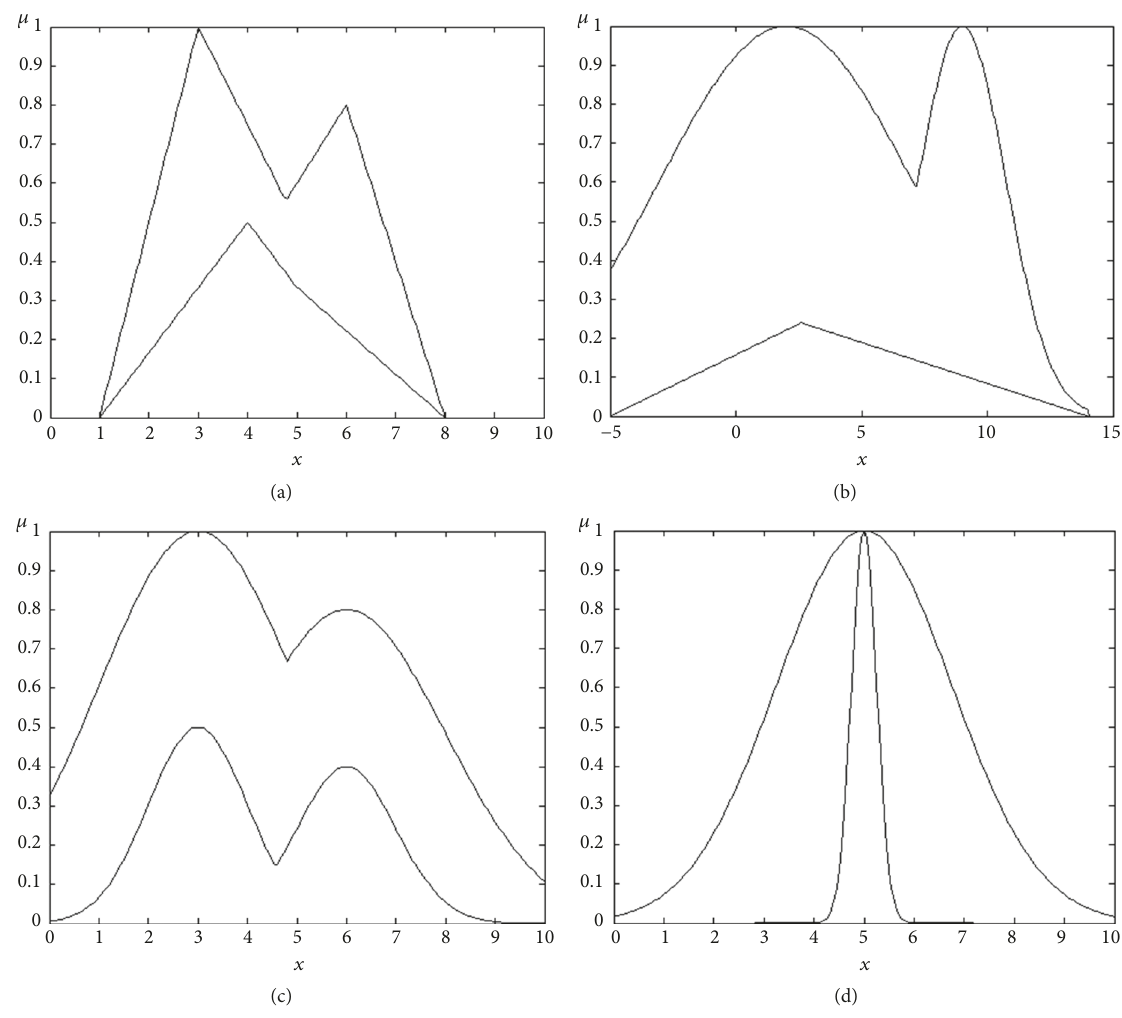
Figure 2: FOU graphs of four examples; (a) example 1, (b) example 2, (c) example 3, and (d) example 4.